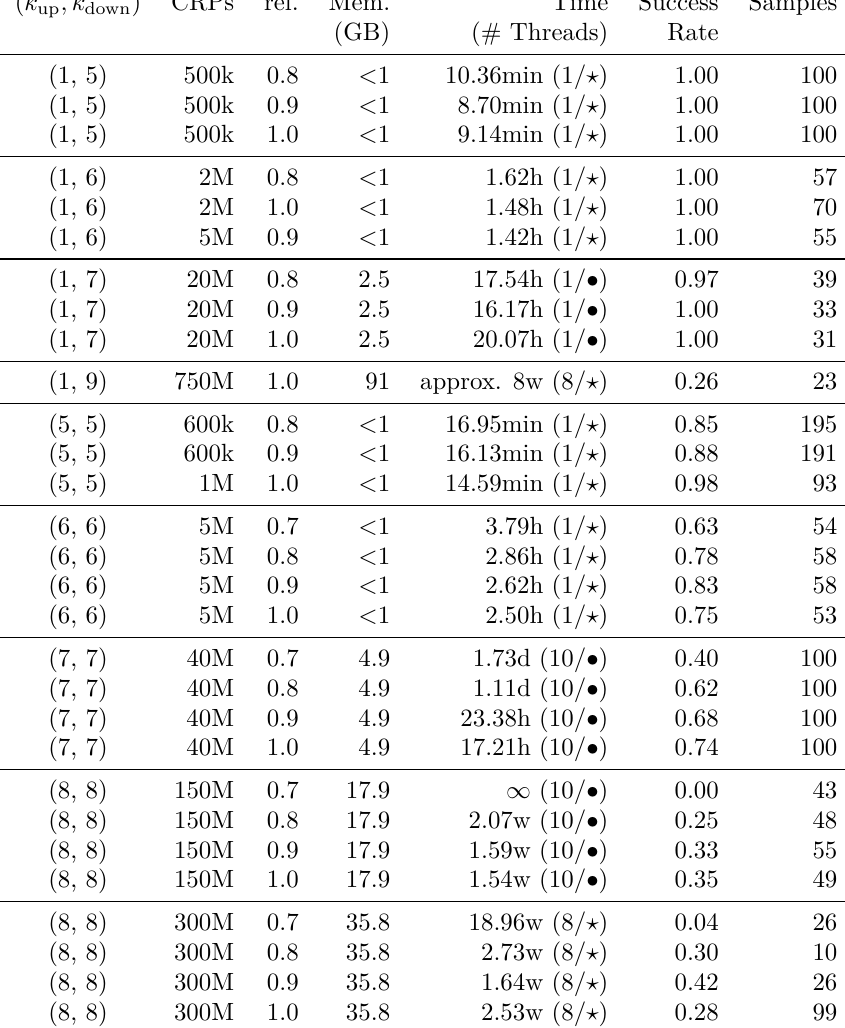
Table 1: Overview of Divide-and-Conquer-Attacks on 64-bit ( k up , k down )-Interpose PUFs. For each size and reliability, the best-performing number of CRPs is shown, defined as the setting that gave the shortest time to first success with our software; success is defined as final prediction accuracy above 95%. We used two different Intel R (cid:13) Xeon R (cid:13) CPU types, namely Gold 6130 at 2.1GHz ( ? ) and E5-2630 v4 at 2.2GHz ( • ). For larger experiments, we allowed the use of up to 10 parallel threads to achieve faster training times; note however that for purely technical reasons the speed-up we observed did not exceed 4. Training times across different CPU types are not compared against each other. Additionally to the number of CRPs shown in the table, the attacker was provided with a test set containing an additional 10 4 challenge-response